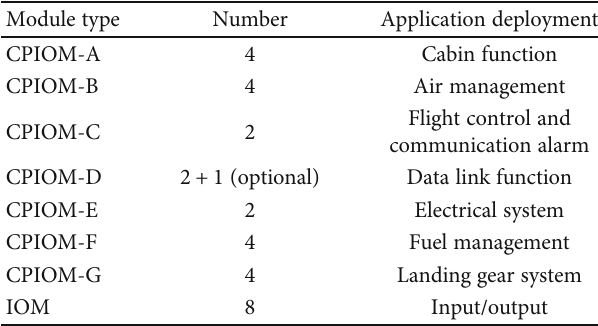
Figure 1: Model of the IMA system. Table 1: CPIOMs in the A380.